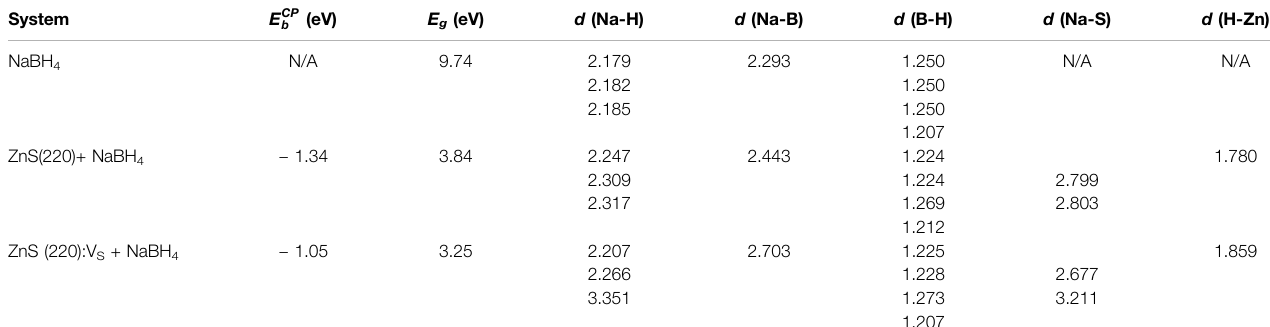
TABLE 3 | Calculated adsorption energy of NaBH 4 bound onto ZnS(220) in its pristine and sulphur de fi cient form and electronic band gap together with the accompanying bond lengths (values reported in